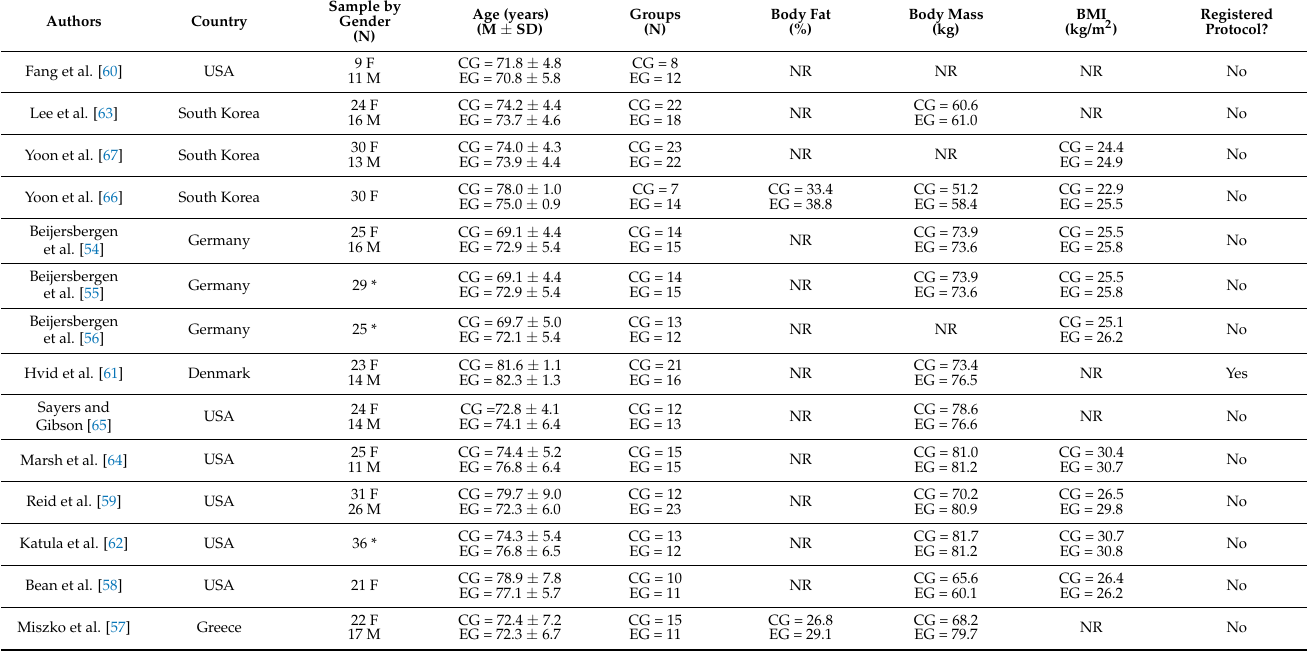
Abbreviations: N, number; M, mean; SD, standard deviation; CG, control group; EG, experimental group; F, female; M, male; USA, united states of America; BMI, body mass index; kg, kilograms; NR, not reported. *, date unreported gender